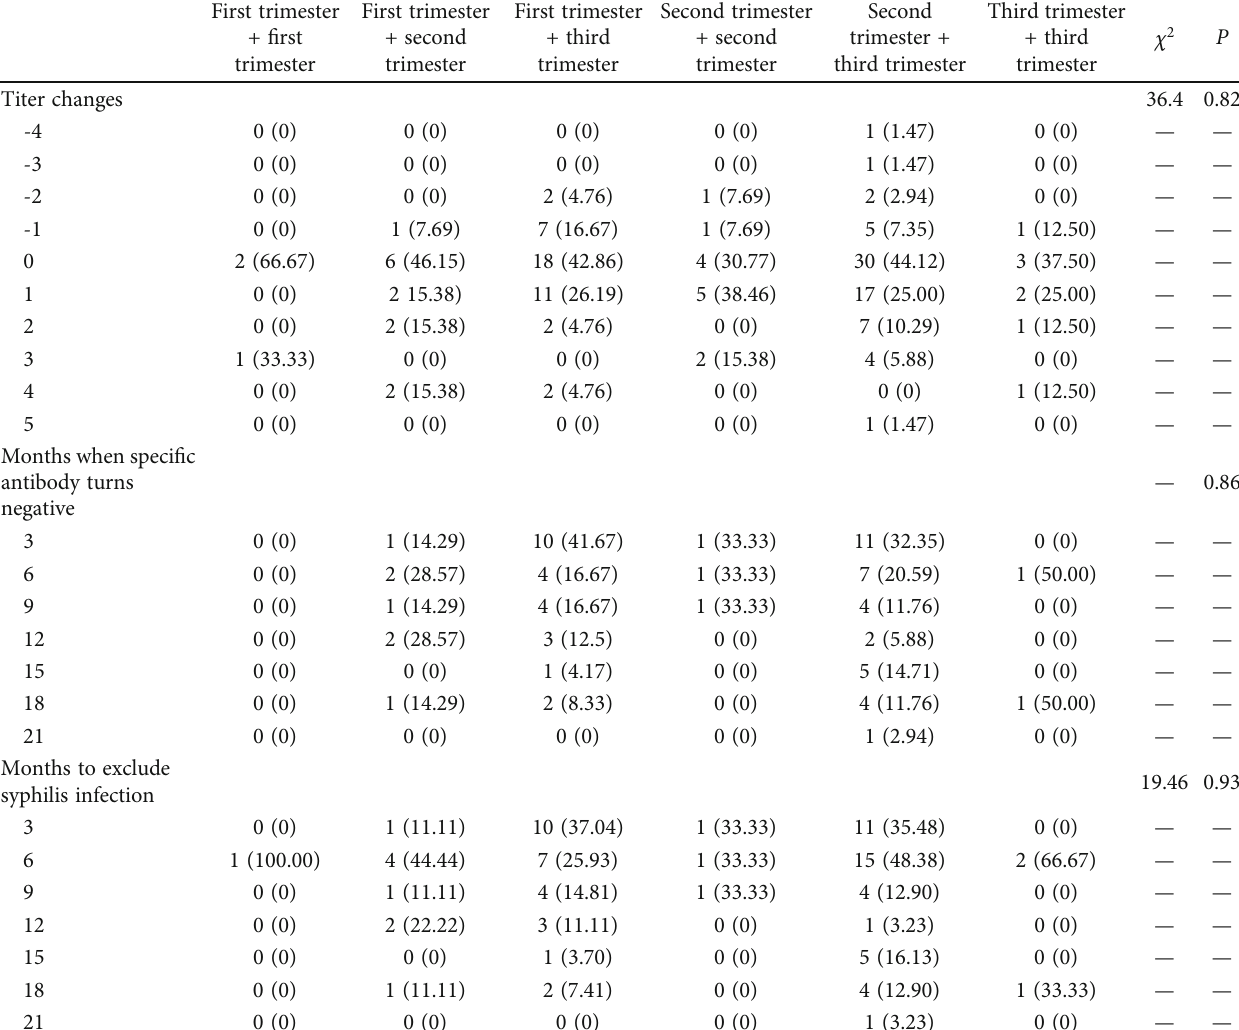
Table 7: Comparison of results features of two courses of treatment at di ff erent stages of pregnancy. First